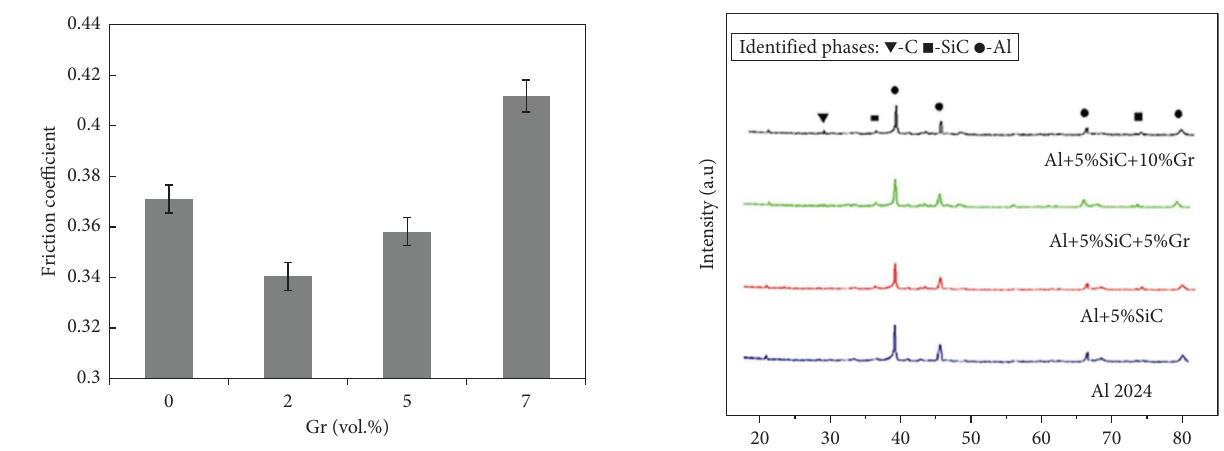
Figure 7: 'e dry sliding friction coefficient of Al/2SiC/Gr hybrid nanocomposites with different amounts of Gr [69]. Figure